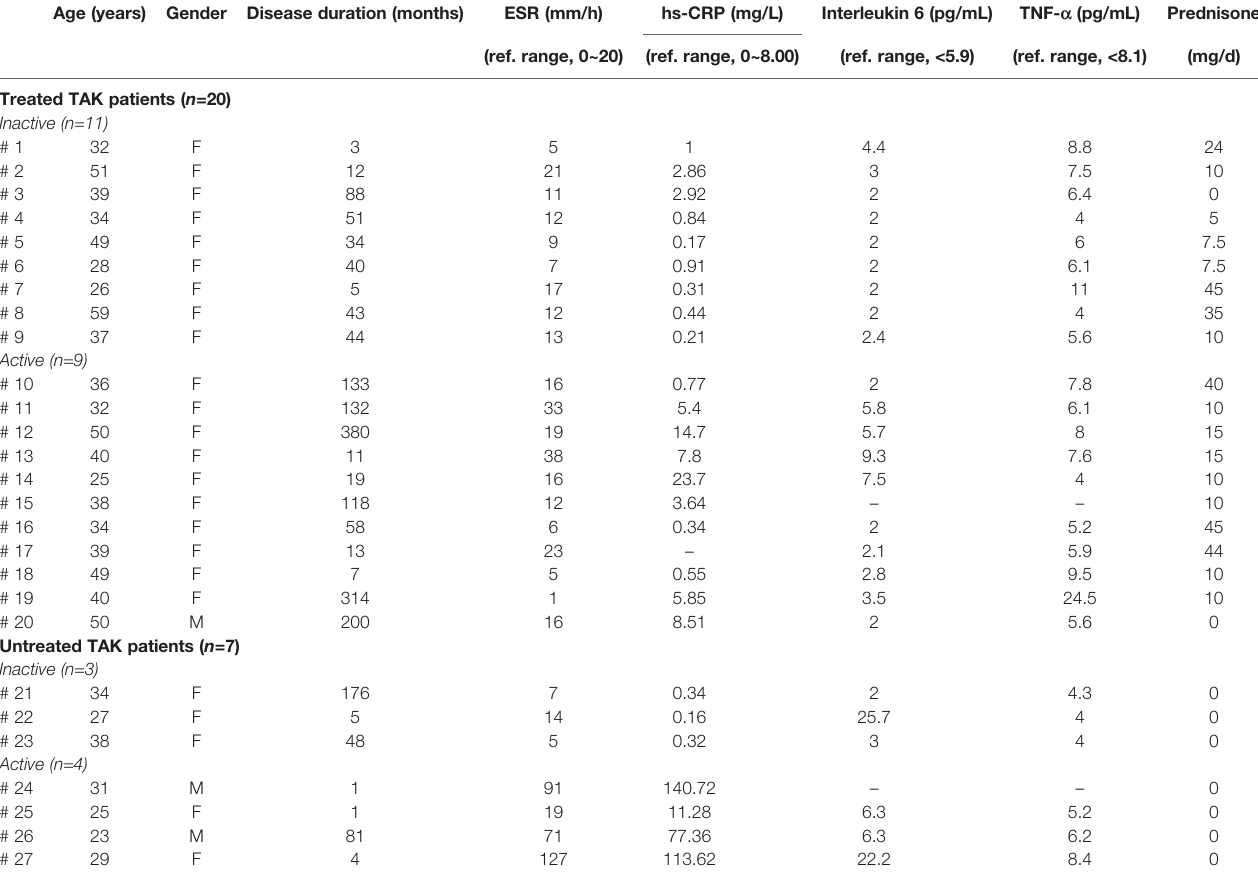
TABLE 1 | Demographic data and clinical features of patients with Takayasu ’ s arteritis. Age (years) Gender Disease duration